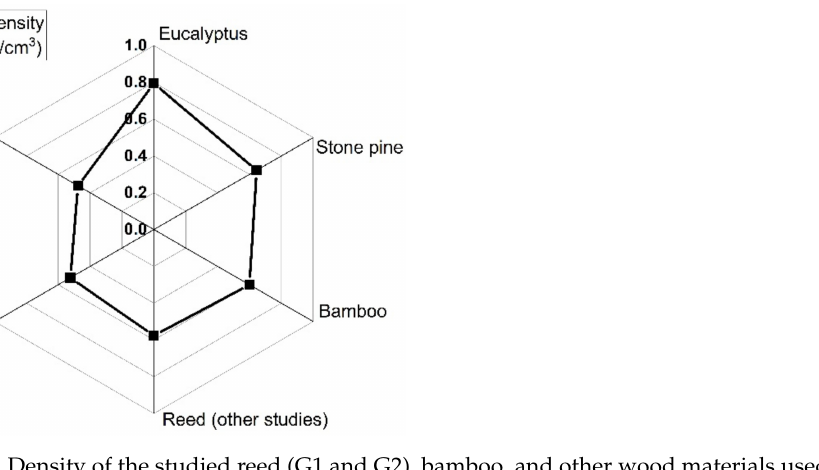
Figure 8. Density of the studied reed (G1 and G2), bamboo, and other wood materials used in the